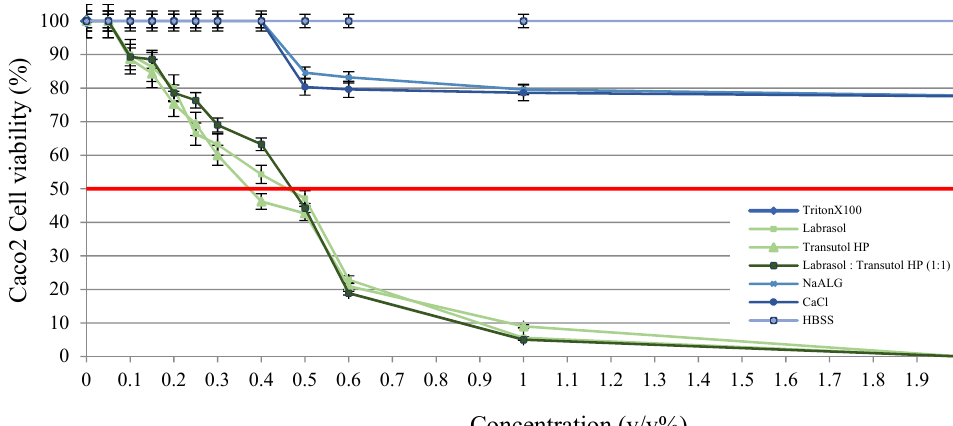
Figure 7. Results of in vitro cytotoxicity measurement of the applied excipients and bead components for the formulation of sodium-alginate beads containing MCH. Bead forming sodium-alginate and calcium chloride dehydrate did not show substantial toxicity, while penetration enhancer excipients (Labrasol, Transcutol HP) seemed to be toxic at higher concentration. Triton-X was used as a positive control; the phosphate-buffered solution (PBS)-treated group was the negative control. Each data point represents the mean ± SD, n =